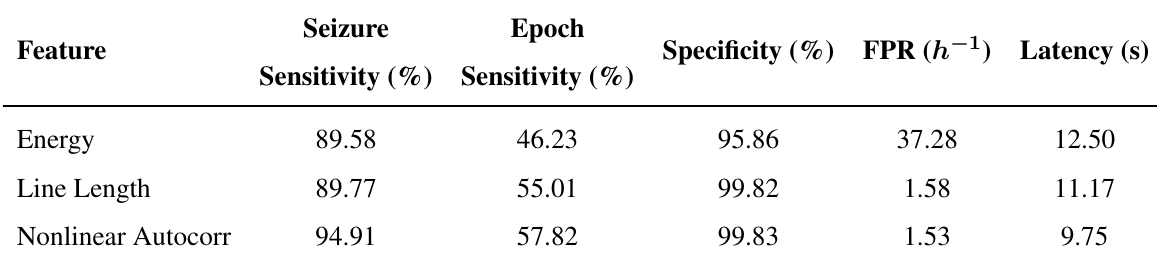
N = 512 . FPR, false positive rate; Nonlinear Autocorr, nonlinear autocorrelation.